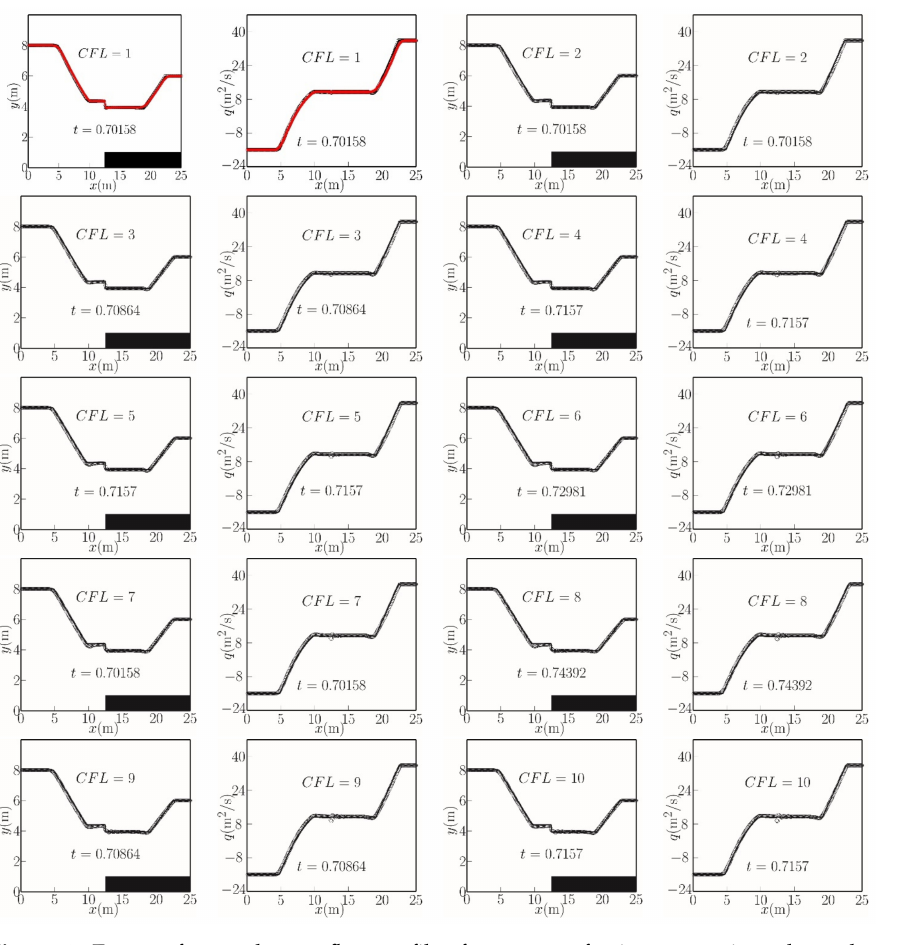
Figure 4. Free surface and mass flux profiles for two rarefaction waves in a channel containing a bed step at a given time instant. Rosatti and Begnudelli [23]’s analytical solution (solid lines), well-balanced scheme [22] (red circles), and TVD-LTS predictions (open circles) for CFL = 1 to 10. The solid rectangle indicates the bed